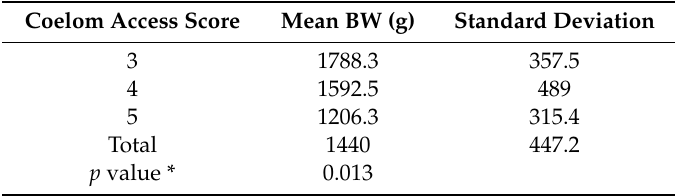
Table 4. Correlation between the access score and weight.